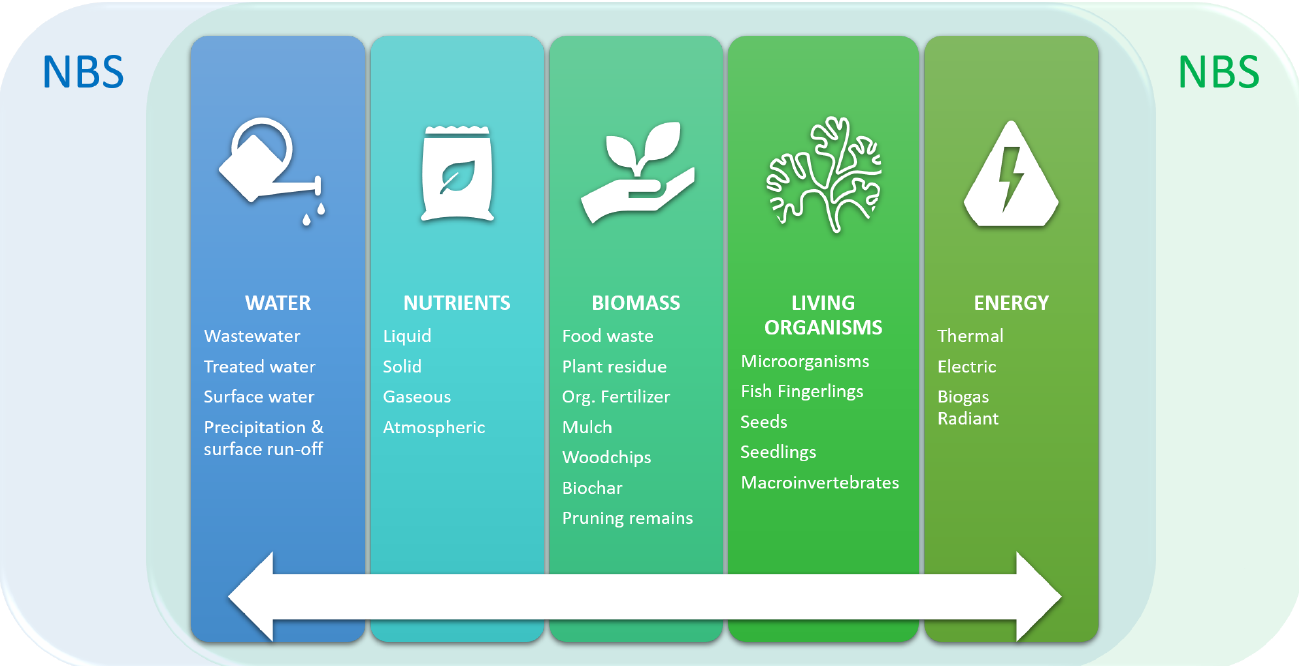
Figure 5. Main types of streams and respective categories of inputs required for the operation and maintenance of NBS and/or outputs potentially produced by NBS in circular cities.